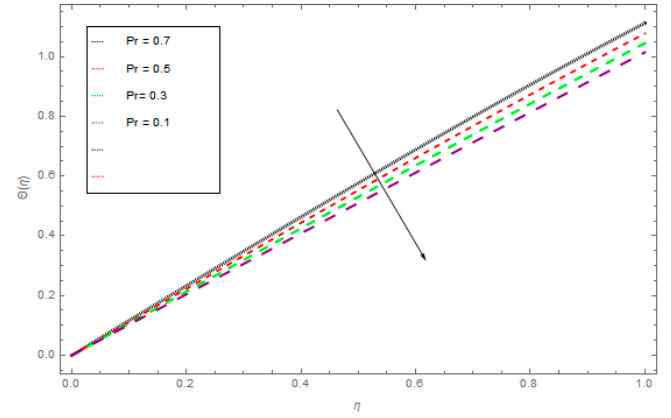
Figure 5. The influence of γ on s ( η ) when Ω = 1, ρ = 1, σ = 0.5, k = 1, M = 1.